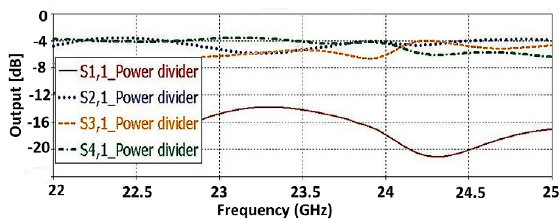
Figure 2. Electric field of three-way H-plane SIW power divider. Figure 3. Scattering parameters of the three-way H-plane SIW power divider.